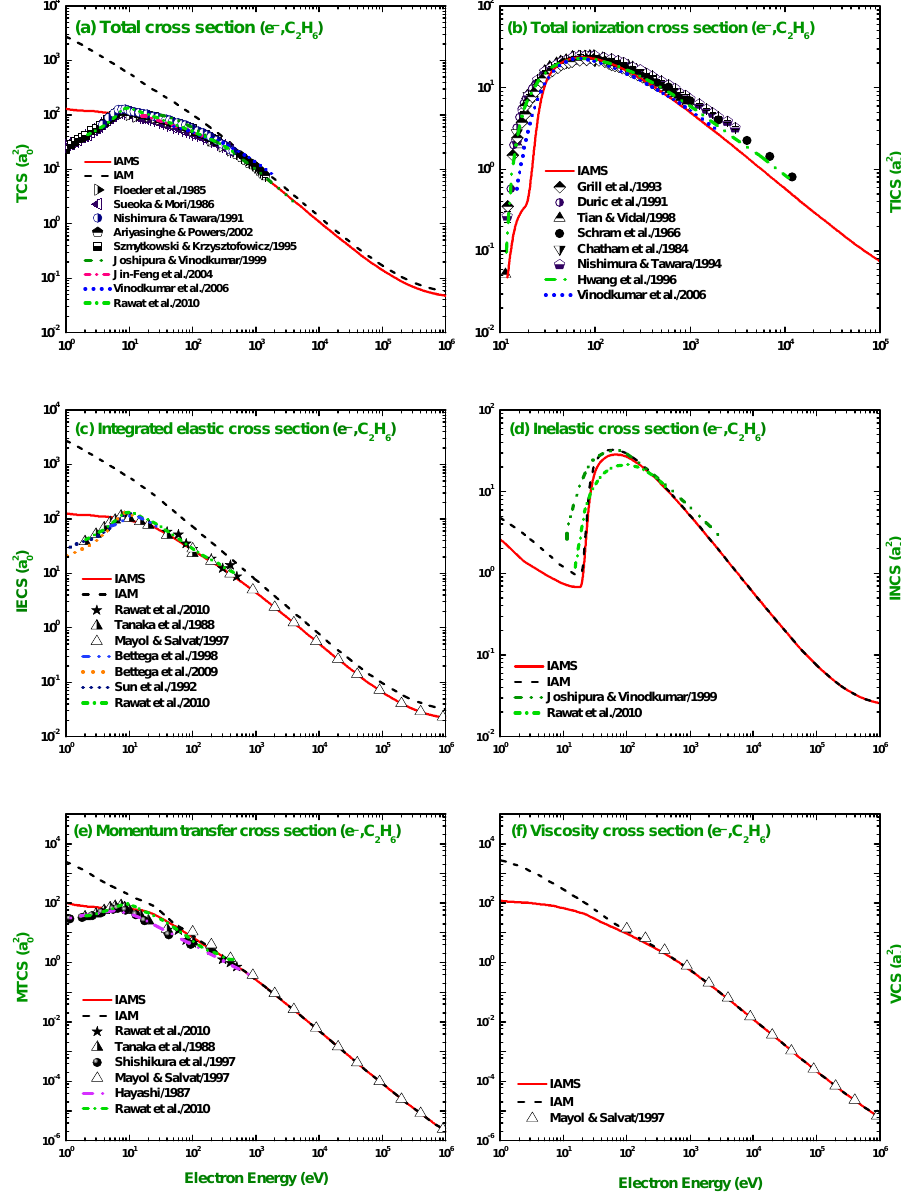
) for the scattering of 0